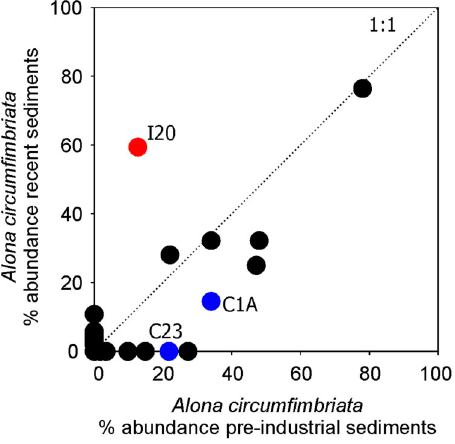
Figure 5. Change in the relative abundance of Alonacircumfim- briata between present-day and pre-industrial sediment sam- ples. Based on a comparison of the top of the sediment core (representing present-day conditions) with a bottom sample (pre- industrial) from 50 lakes in the Canadian sub-Arctic. Black circles represent 47 lakes from the only regional cladoceran survey in the Canadian sub-Arctic, spanning present-day treeline in the Northwest Territories (data recalculated from [34]). Blue circles represent the control lakes (C23, C1A) from this study. The red circle represents drilling sump-impacted Lake I20. The 1:1 line is also